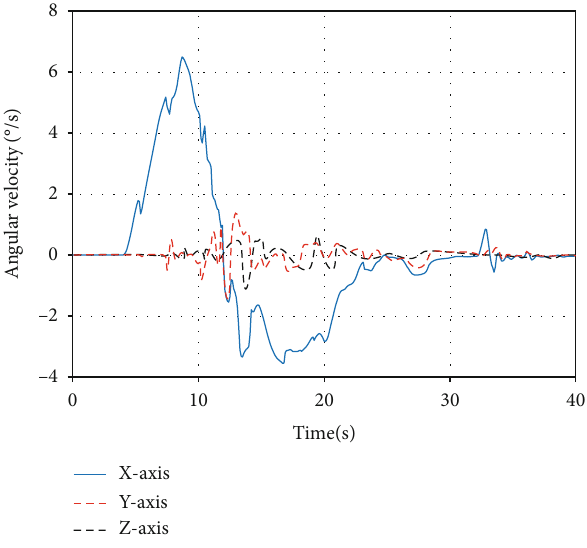
Figure 6: Angular velocity of payload module with PD